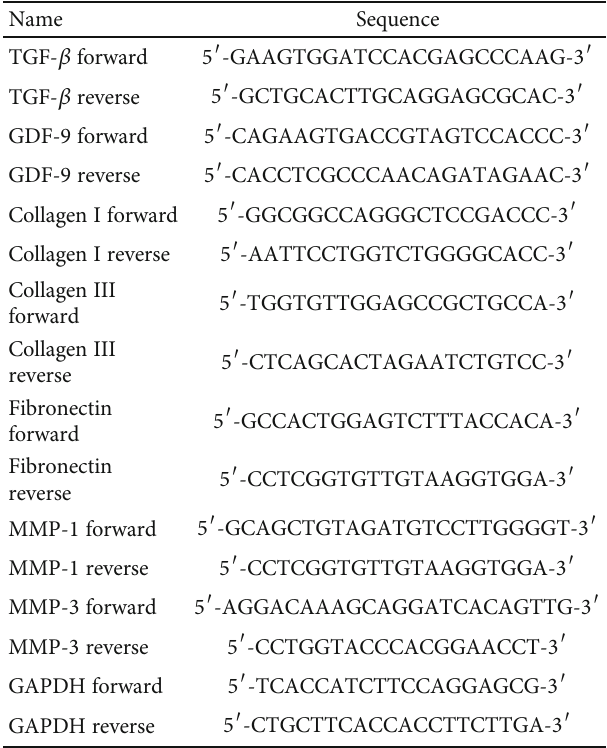
Table 2: Quantitative real-time PCR